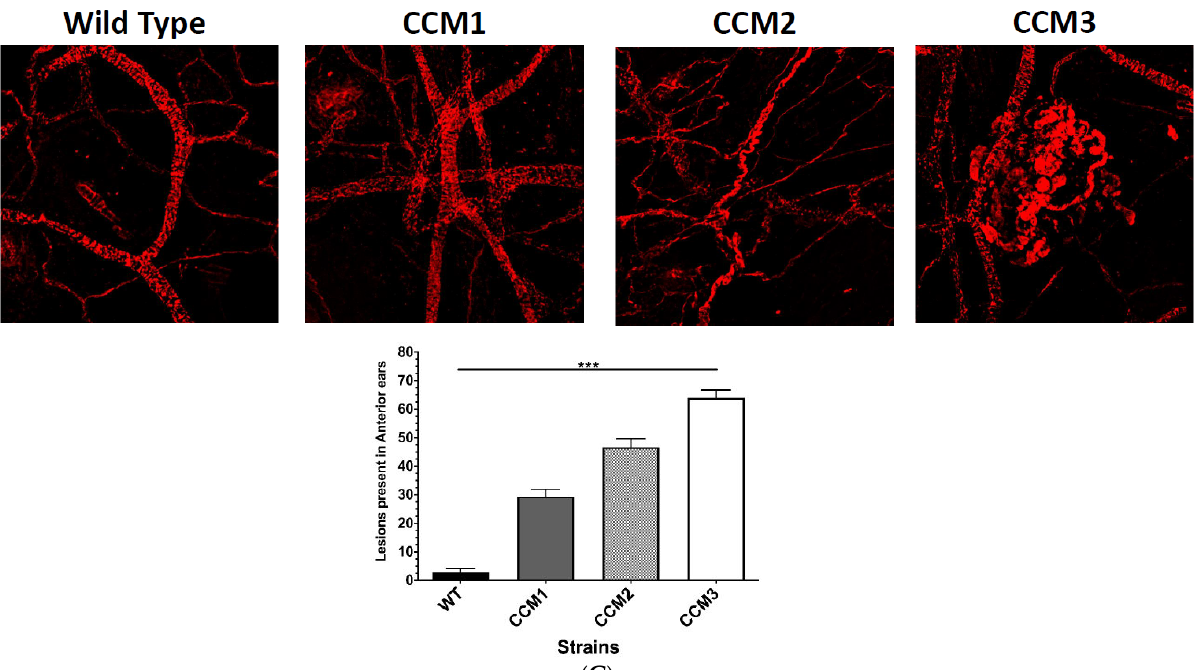
Figure 3. mPR ‐ specific actions on nPR( − ) ECs are sufficient for blood–brain barrier (BBB) disruption and formation of subcutaneous lesions in vivo. Hemizygous Ccms (1, 2, and 3) mutants and WT (C57 BL/6 J) mice were injected with mPR ‐ specific PRG treatment (a cocktail of PRG + MIF, 100 mg/kg body weight) in peanut oil (vehicle), 5 days a week for 30, 60, and 90 days, respectively. ( A ) BBB permeability was significantly increased only in our 90 ‐ day treatment groups for all 3 Ccm mutants, demonstrating that increased microvascular permeability in the brain is associated with a combina ‐ tion of chronic exposure to mPR ‐ specific PRG actions and Ccm deficiency. ( B ) Subcutaneous vessel diameters in posterior sections of ears were classified into four subgroups based on the range of the vessel size (diameters): group ‐ I (8–9 μ M), group ‐ II (9–10 μ M), group ‐ III (10–11 μ M), and group ‐ IV (11–12 μ M). Significantly decreased percentage of vessels was found in Ccm2 / Ccm3 within group ‐ I (8–9 μ M), compared to WT in the 90 ‐ day treatment group, suggesting that more vessels in Ccm2 / Ccm3 mutants are distributed in larger diameter groups under mPR ‐ specific PRG actions. In ‐ deed, the significantly increased percentage of larger vessels in Ccm3 mutant was found in group ‐ II (9–10 μ M) compared to WT, and Ccm2 is the only mutant to display vessels in the largest size group, group ‐ IV (11–12 μ M) under mPR ‐ specific PRG actions. ( C ) Subcutaneous vessel lesions in the ante ‐ rior side of mice ears in all Ccm (1, 2, and 3) mutant strains can be visually distinguished in the 90 ‐ day treatment groups compared to WT, with Ccm3 mutant having the largest number of CCM le ‐ sions. For Evans blue assays, statistical analysis was generated using one ‐ way ANOVA with either Kruskal–Wallis test or uncorrected Fisher’s LSD test where appropriate. All treated mice, upon com ‐ pletion of the last injection, were injected with Evan’s blue dye (EBD) (500 μ G/25 G mouse) which was allowed to circulate for 3 h. Fluorescence data were then measured from the homogenized brain tissue and converted to μ g/mL based on standard curves generated in the extraction buffer, and normalized based off the tissue weight ( μ g Evans blue/mg tissue) followed by controls. In ear tis ‐ sues, statistical significance was performed using unpaired Student’s t ‐ test (*, ** and *** above graphs indicate p ≤ 0.05, 0.01, and 0.001, respectively).